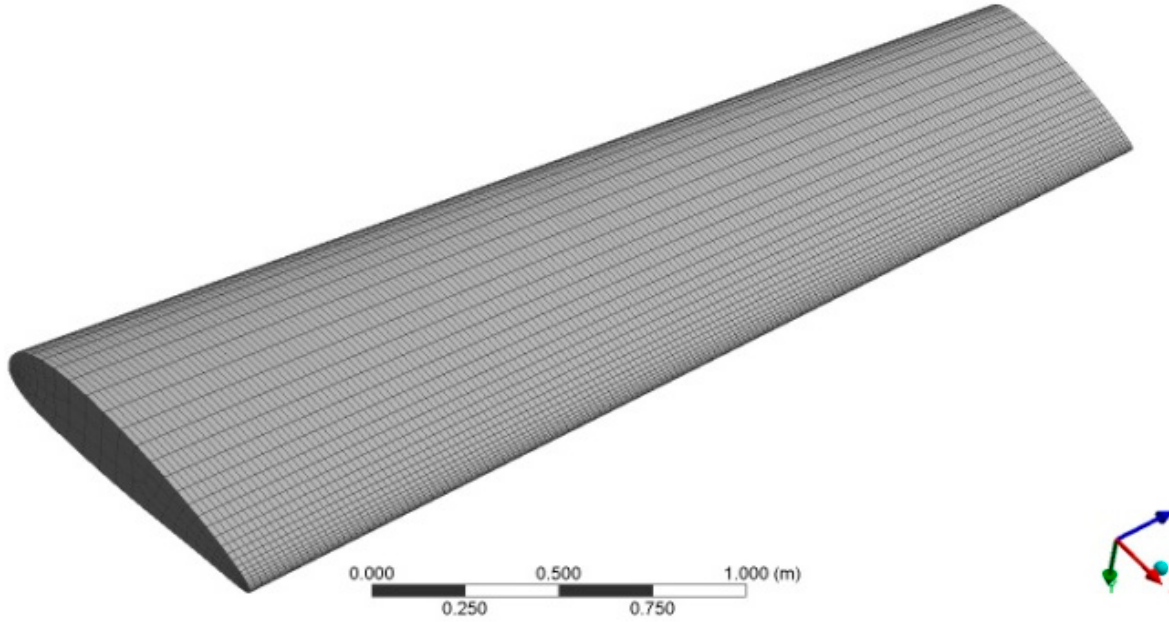
Figure 6. Discretized structure of an aircraft wing for aero-structural simulation.